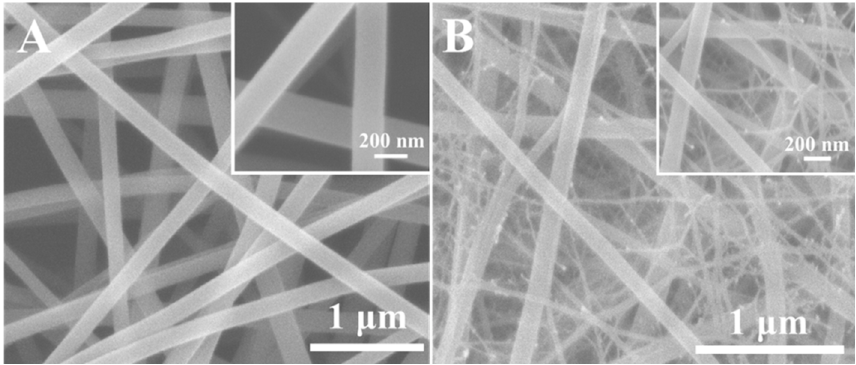
Figure 3. Representative SEM images of ( A ) AgNO 3 /PVP nanofibers and ( B ) AgNO 3 /Ni(NO 3 ) 2 /PVP nanofibers, respectively. The insets show corresponding SEM images with a higher magnification.